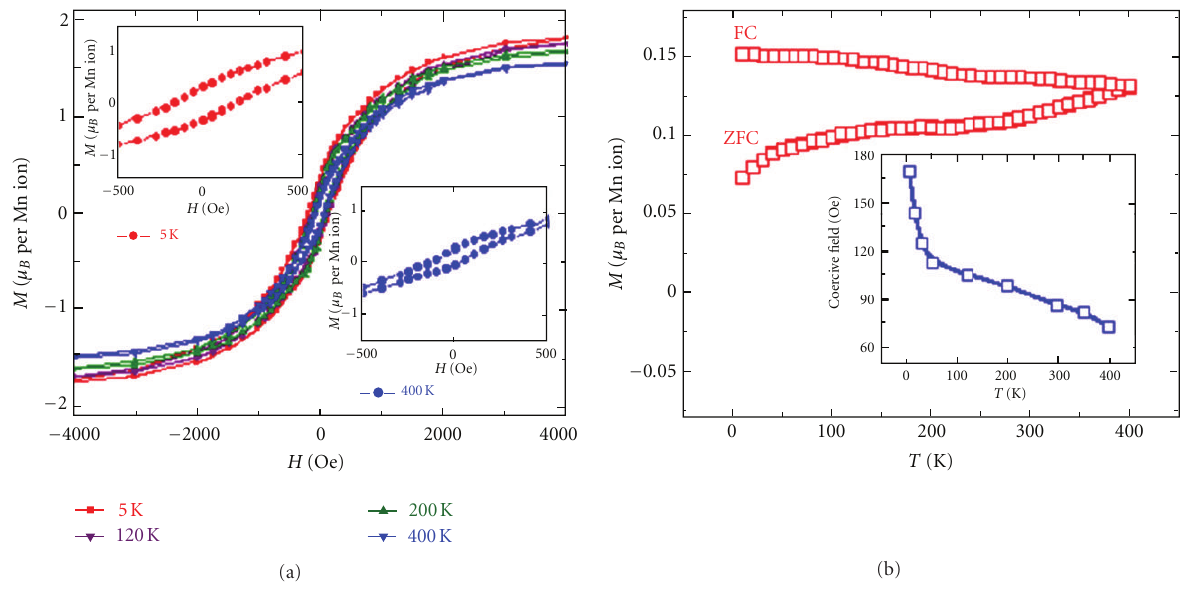
Figure 14: Magnetic properties of Mn 0 . 05 Ge 0 . 95 QDs. (a) Hysteresis loops at 5, 120, 200, and 400 K. (b) ZFC and FC magnetization curves under a magnetic field of 100Oe. Temperature-dependent coercivity is displayed in the inset. Reproduced from [17]. Copyright ©2010, Macmillan Publishers